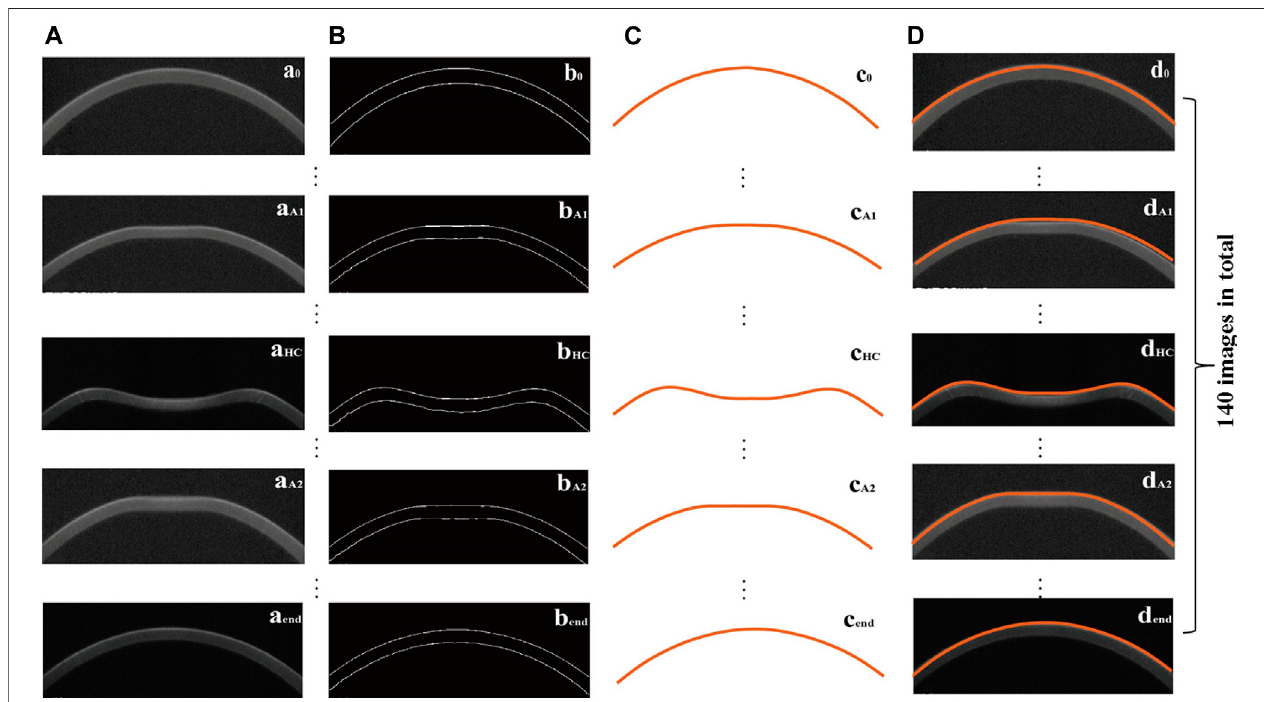
FIGURE 3 | Original corneal image(a n ) (A) , the corresponding processed image (b n ) (B) , extracted corneal anterior surface contour (c n ) (C) , and the position of the extracted corneal anterior surface contour in the original image (d n ) (D) , where n (cid:1) 0 (initial state), A 1 ( fi rst applanation), HC (highest concavity), A 2 (second applanation), end.